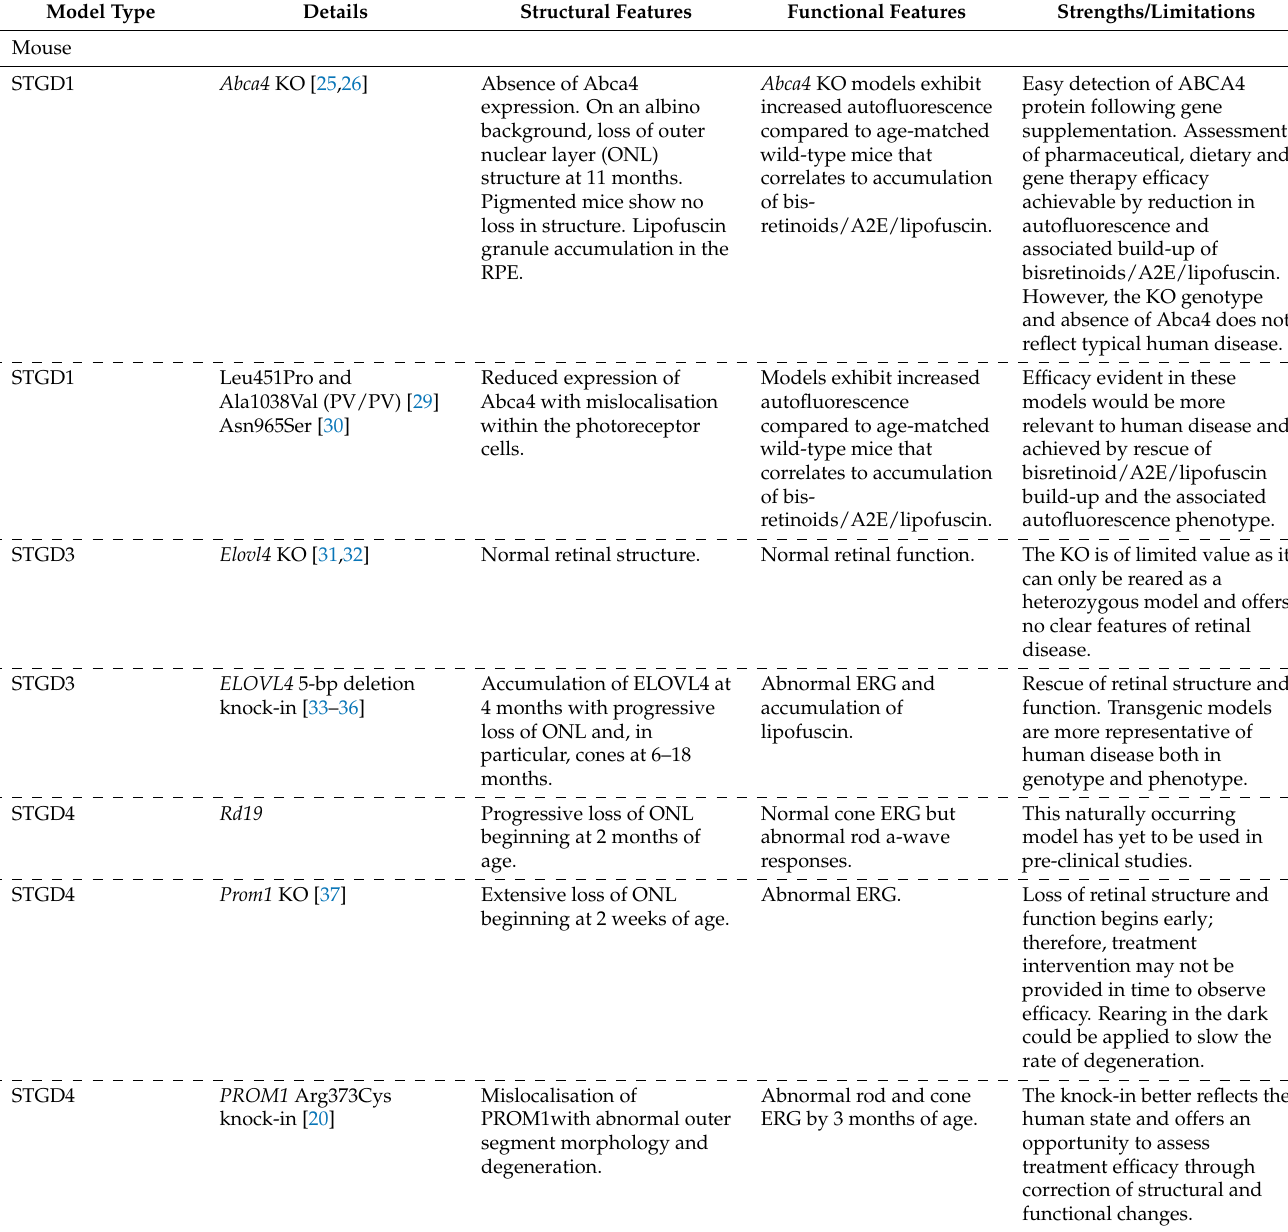
Table 1. Summary of experimental models relevant for pre-clinical studies of Stargardt disease therapies. A2E = N -retinylidene- N- retinylethanolamine; ABCA4 = ATP-binding cassette transporter protein 4; ELOVL4 = elongation of very-long-chain fatty acids 4; ERG = electroretinogram; KO = knockout; ONL = outer nuclear layer; PROM1 = prominin 1; Rd19 = retinal degeneration model 19; RPE = retinal pigment